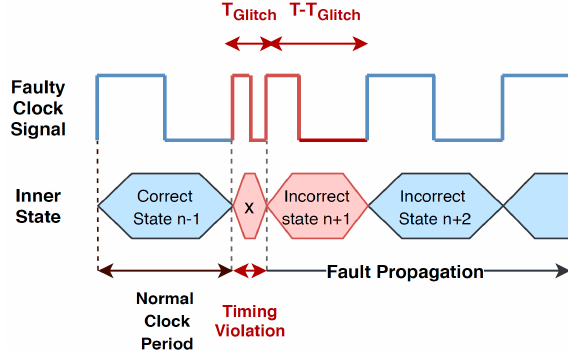
Figure 4. Representation of clock glitch and fault injection [17].